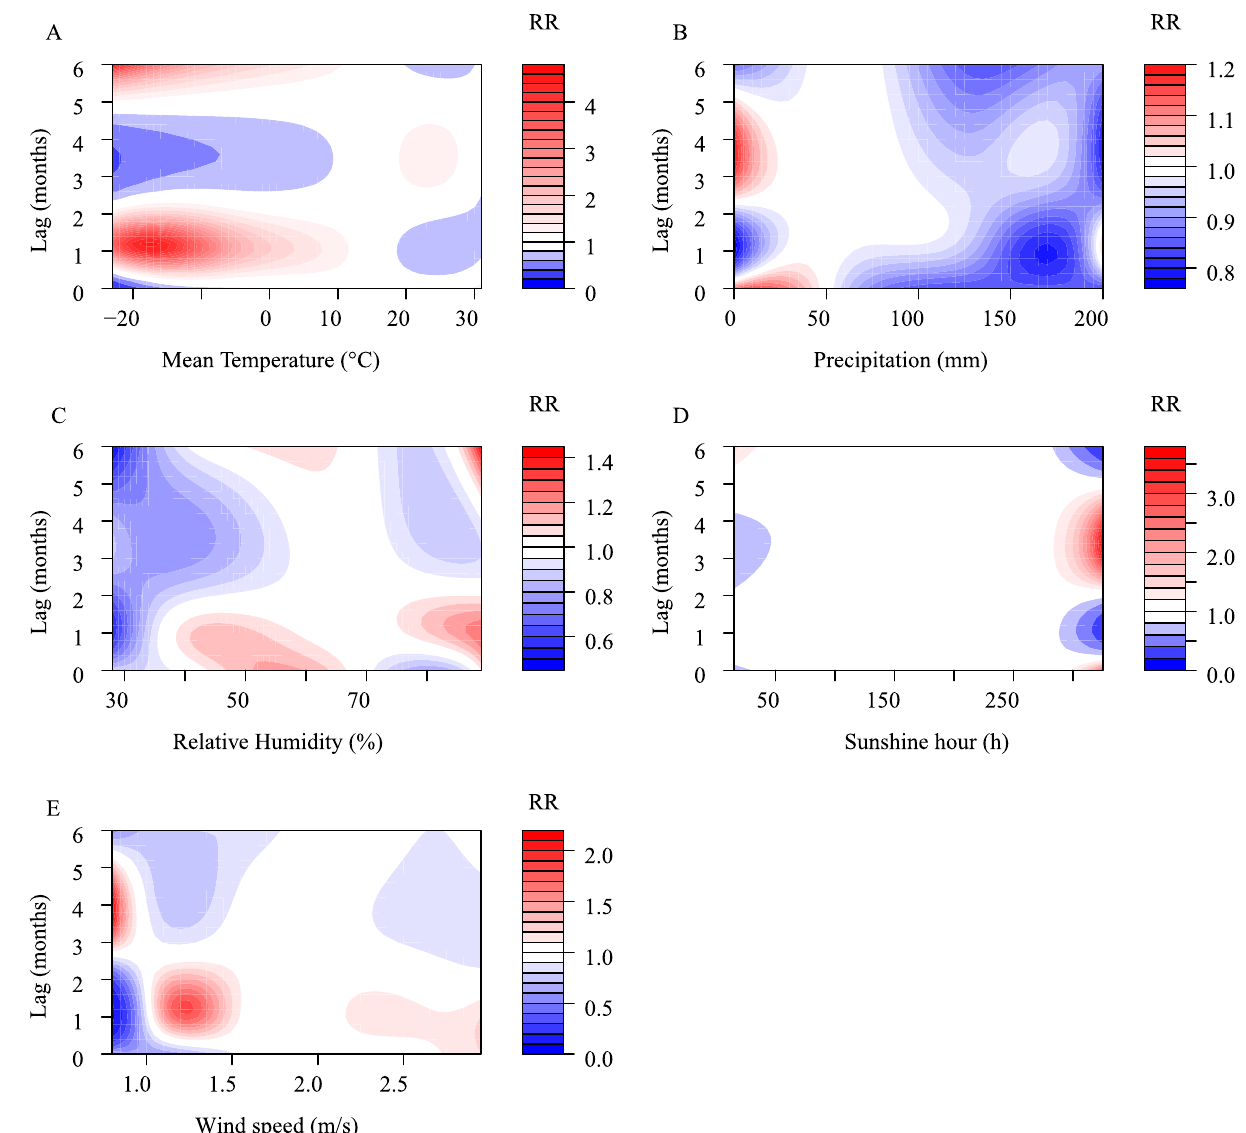
Figure 4. Contour plot of the exposure–response relationship between the incidence of HFRS and five meteorological conditions in the univariate model. The Y-axis represents the lag period from 0 to 6 months. The x-axis represents the range of observations for each variable. RR stands for relative risk, red stands for RR > 1, white stands for RR = 1, and blue stands for RR <